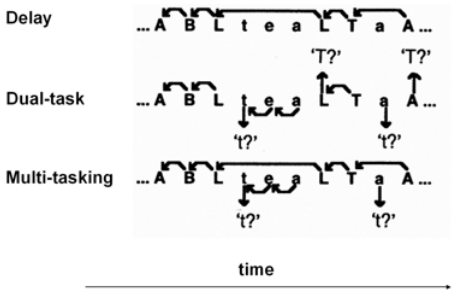
Figure 4. Behavioural tasks. Single-letters (upper or lower-case) from the word ‘‘tablet’’ were successively presented and subject’s decisions were recorded using two single response-buttons, one for each hand. Delay condition: subjects decided whether two successively